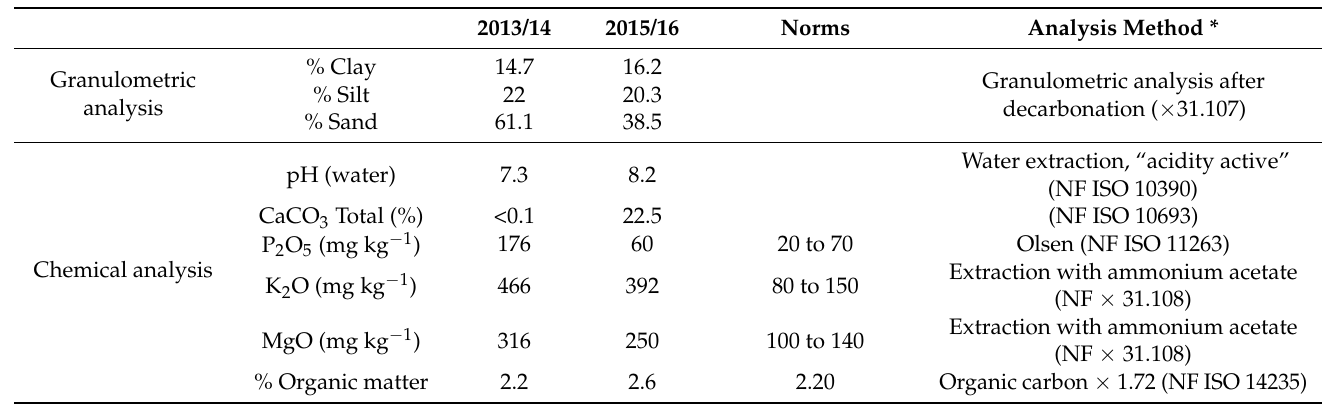
Table 1. Characteristics of the topsoil (0 to 30 cm) before crop establishment in 2013/14 and